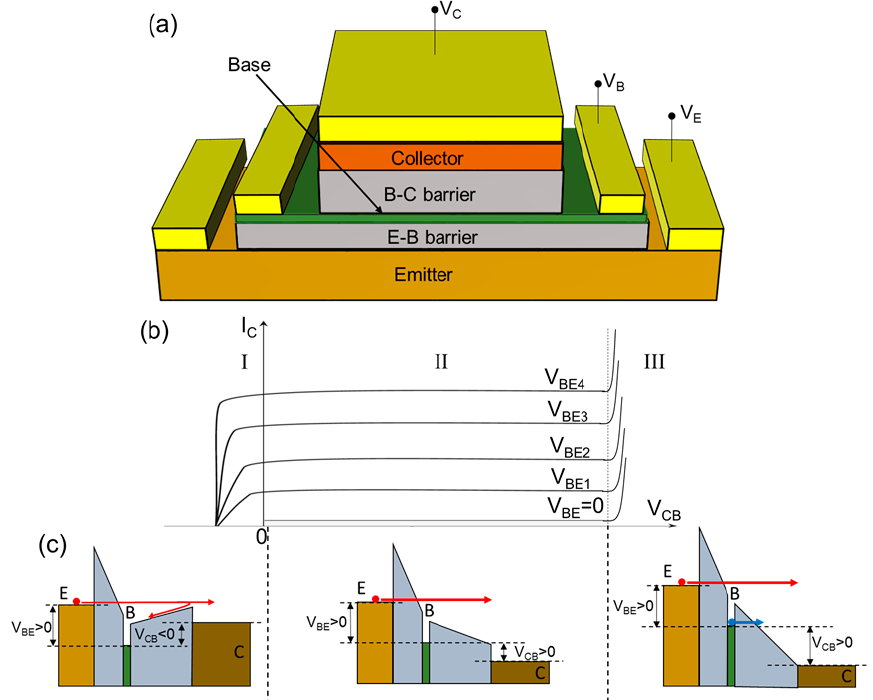
Figure 7. ( a ) Schematic illustration of a hot electron transistor (HET); ( b ) ideal output characteristics I C -V CB for the transistor biased in the common-base configuration (V B = 0 and V BE = V B − V E > 0) for different V BE values; ( c ) energy band diagrams for different V CB biasing regimes.